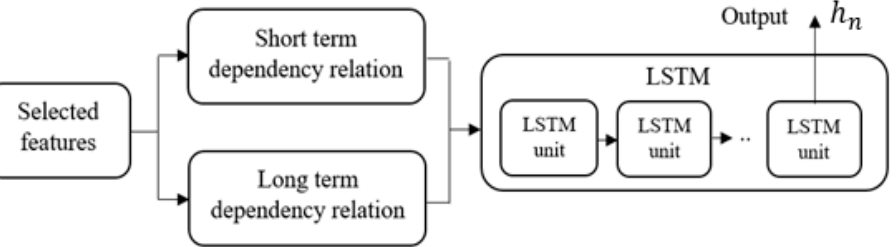
Figure 6. Structure of the LSTM classifier.